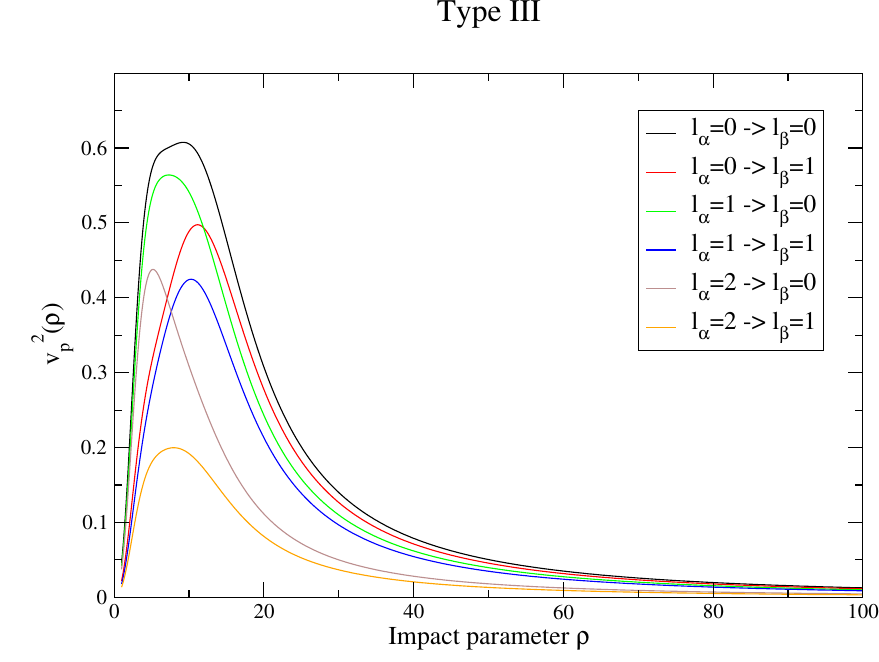
Figure 11. Exact computation of v 2 p ( ρ ) for all channels included in n α = 3 → n β = 2 (Type III).